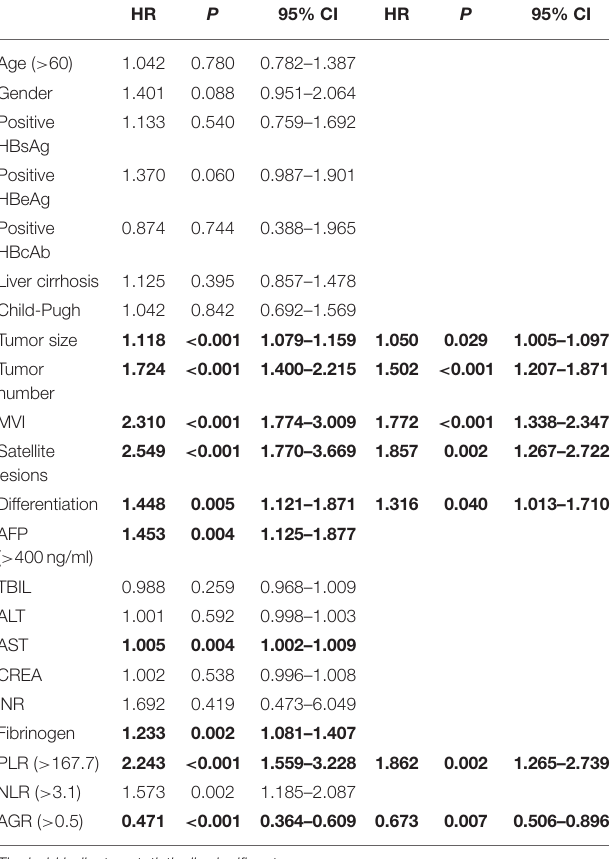
TABLE 3 | Univariate and multivariate analysis of factors related with overall survival in training set.